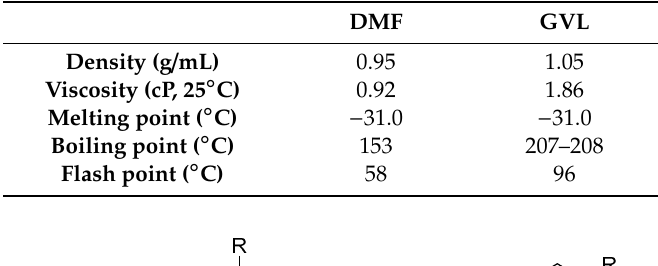
Table 1. Physical properties of DMF vs. GVL.